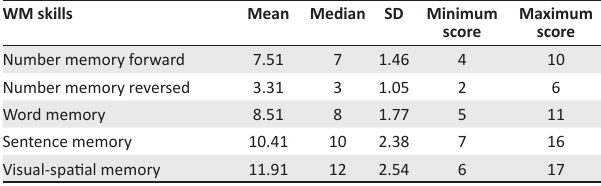
TABLE 1: Results of working memory skills ( n = 35).